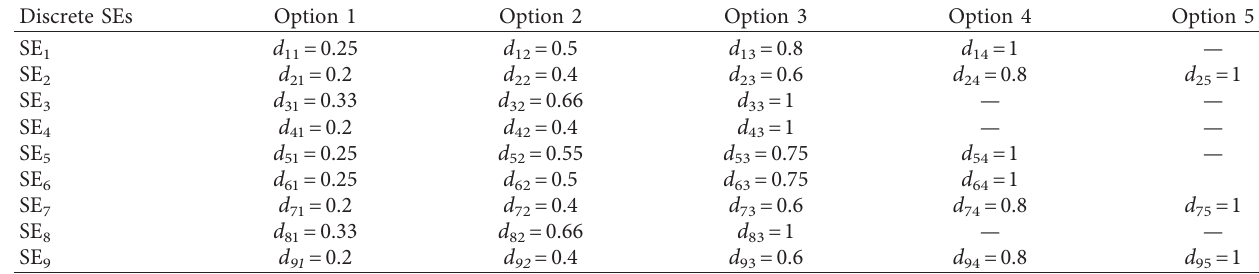
Table 9: Normalizations of discrete SEs.